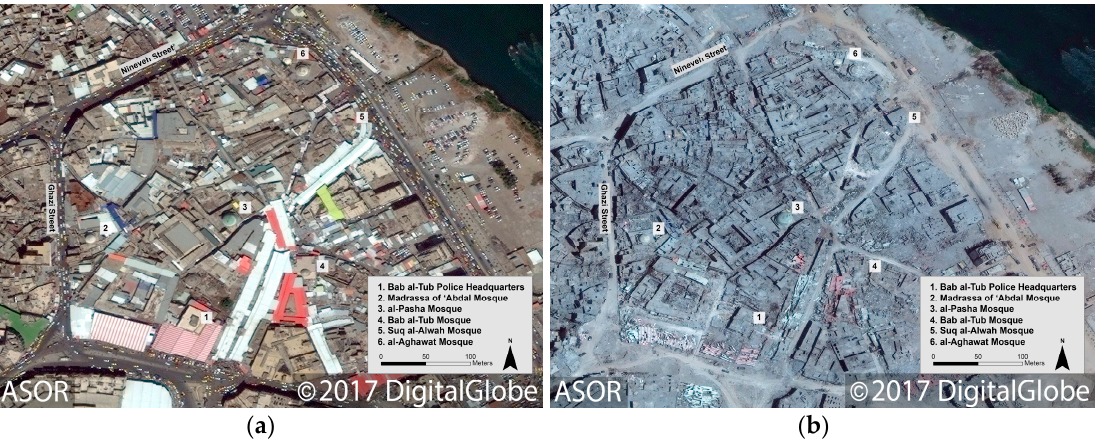
Figure 10. DigitalGlobe satellite imagery of the souq area within the Old City of Mosul: ( a ) prior to the offensive to retake the Old City (DigitalGlobe NextView License; 9 May 2016); ( b ) after recapture by Iraqi forces (DigitalGlobe NextView License; 12 July 2017).